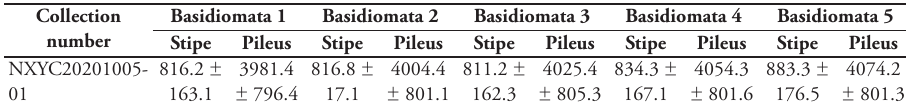
Table 1. Muscarine content in different parts from different basidiomata of the holotype (mg/kg).